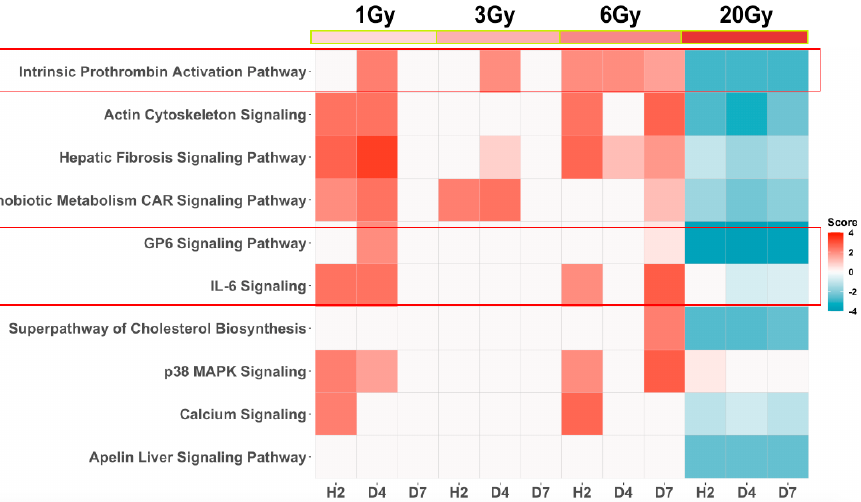
Figure 3. Pathway enrichment analysis of SDTGs ( p ≤ 0.05 and FC ≥ 2) in biopsies collected during the first week after exposure to lethal and sublethal IR doses.